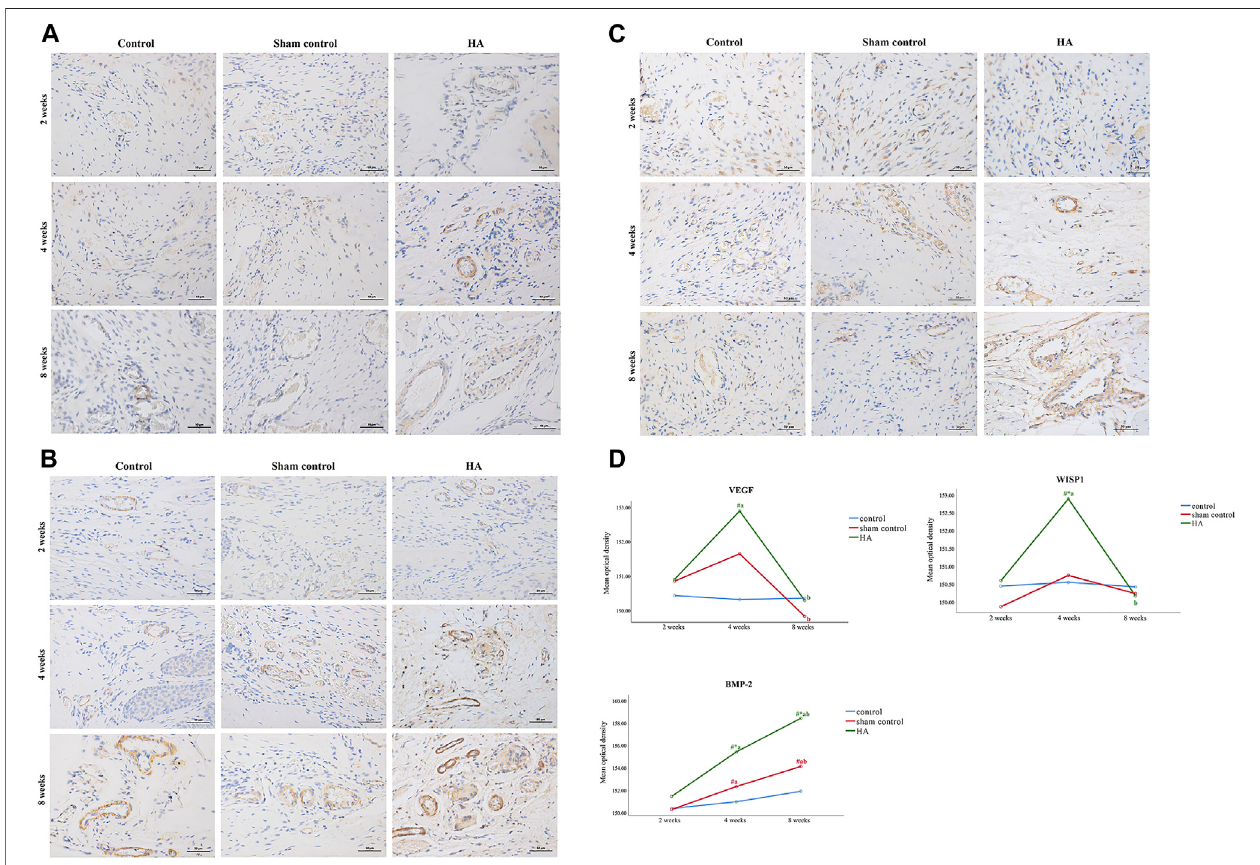
FIGURE 6 | The expression of VEGF, BMP-2, and WISP1 at different time points in the interdental papilla. Representative photomicrograph of VEGF (A) , BMP-2 (B) , and WISP1 (C) immunohistochemistry staining in the interdental papillae. Scale bars (cid:1) 50 μ m. (D) Quantitative analysis of gene expression at different time points. Datarepresentmeans ± SDwithgroupsizesof n (cid:1) 5.(# P < 0.05,HA,shamcontrolgroupcompared tothecontrolgroup;* P < 0.05,HAgroup,controlgroupcompared to the sham control group; a P < 0.05, compared to 2 weeks; bP < 0.05, compared to 4 weeks).